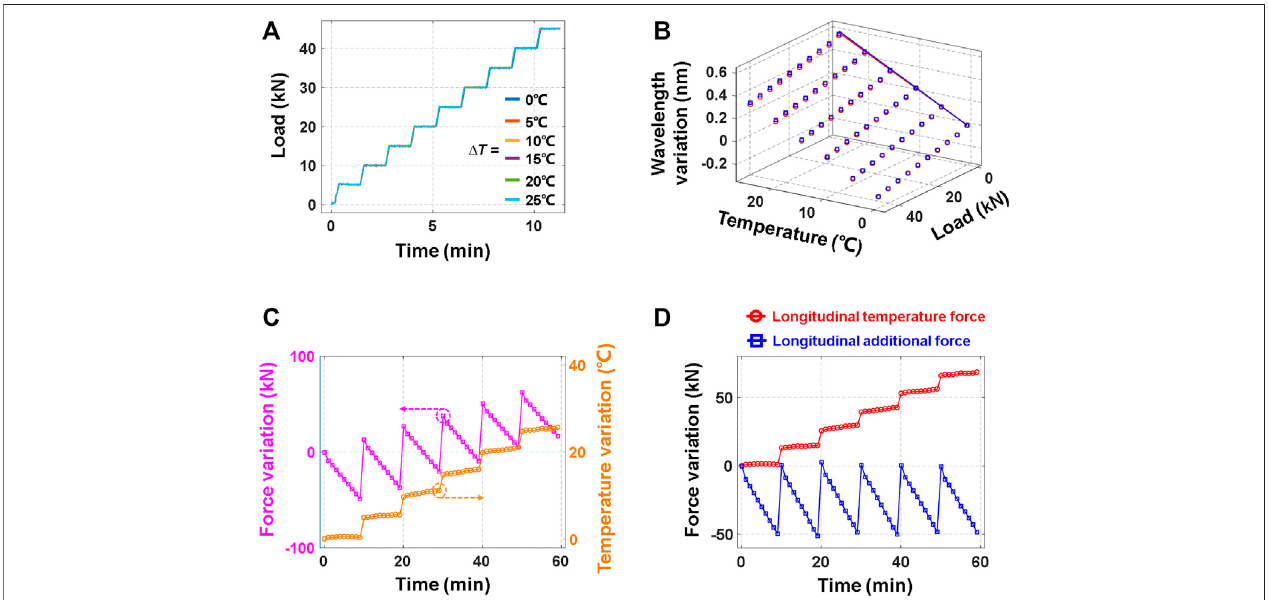
FIGURE 4 | (A) Temperatures and additional force loaded on the rail. (B) Measured Bragg wavelengths corresponding to the two modes under different rail temperatures and additional force situations. (C) Temperatures and additional force extracted from the measured Bragg wavelengths. (D) Retrieved longitudinal temperature force and longitudinal additional